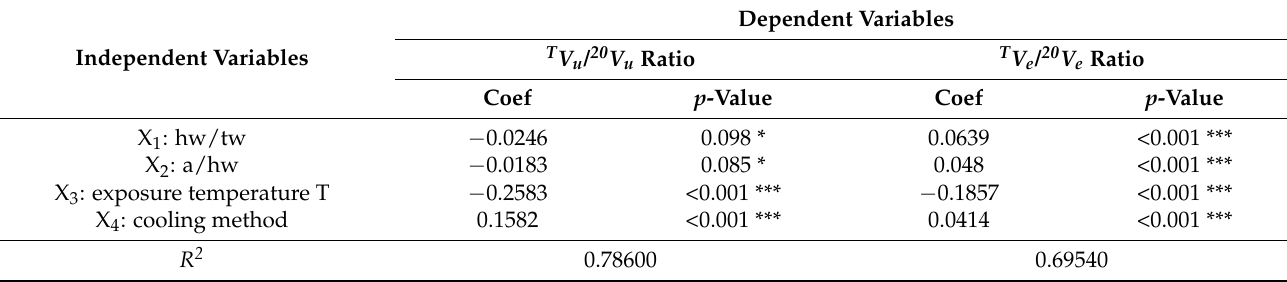
Figure 9. Prediction of resistance reduction through linear regression. ( a ) T V u,pred / 20 V u,pred − T V u,FE / 20 V u,FE scatter plot; ( b ) T V e,pred / 20 V e,pred − T V e,FE / 20 V e,FE scatter plot. Table 2. ANOVA response for the linear regression model.